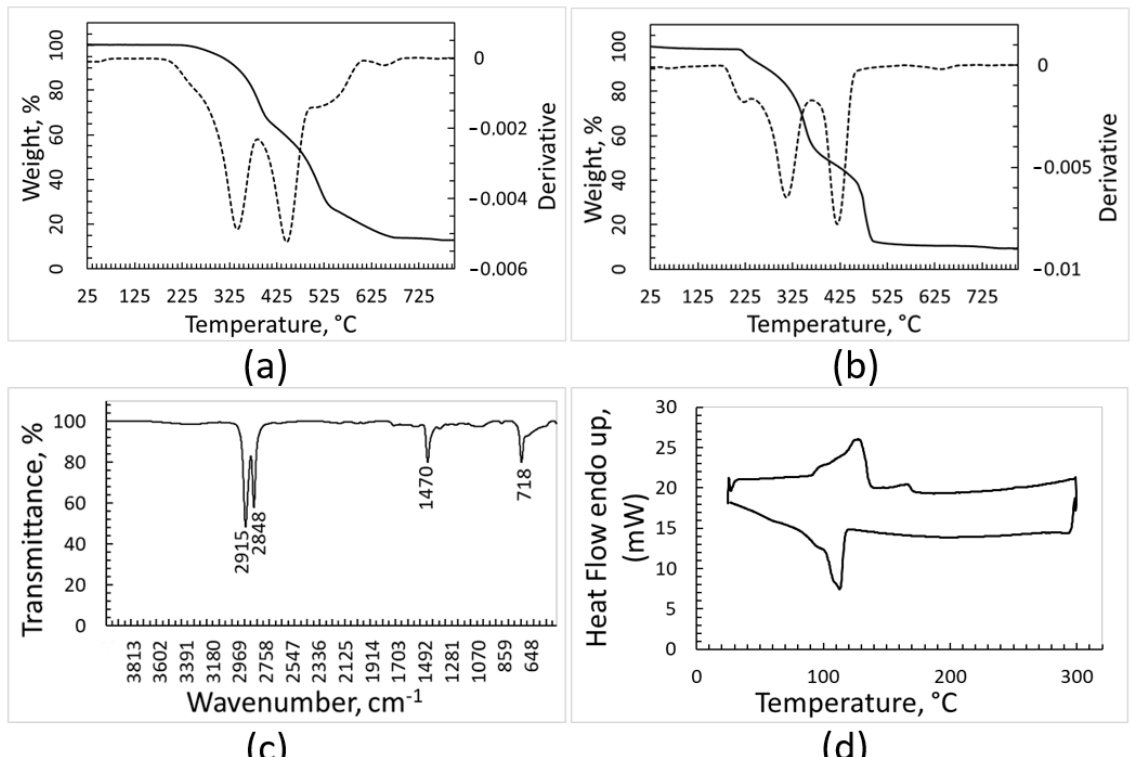
Figure 4. Characterization of the PE fraction: TGA and DTGA (dotted line) curves recorded under argon ( a ), TGA and DTGA recorded under air ( b ), FT-IR spectrum ( c ), DSC heating and cooling curves (upper and lower curve, respectively) recorded under nitrogen atmosphere ( d ).